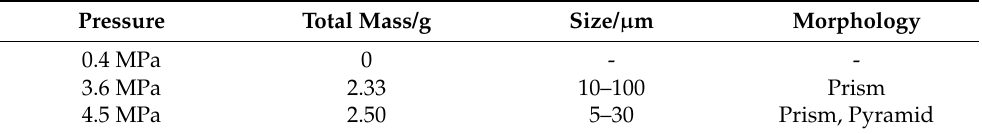
Table 1. Features of GaN crystals grown under different